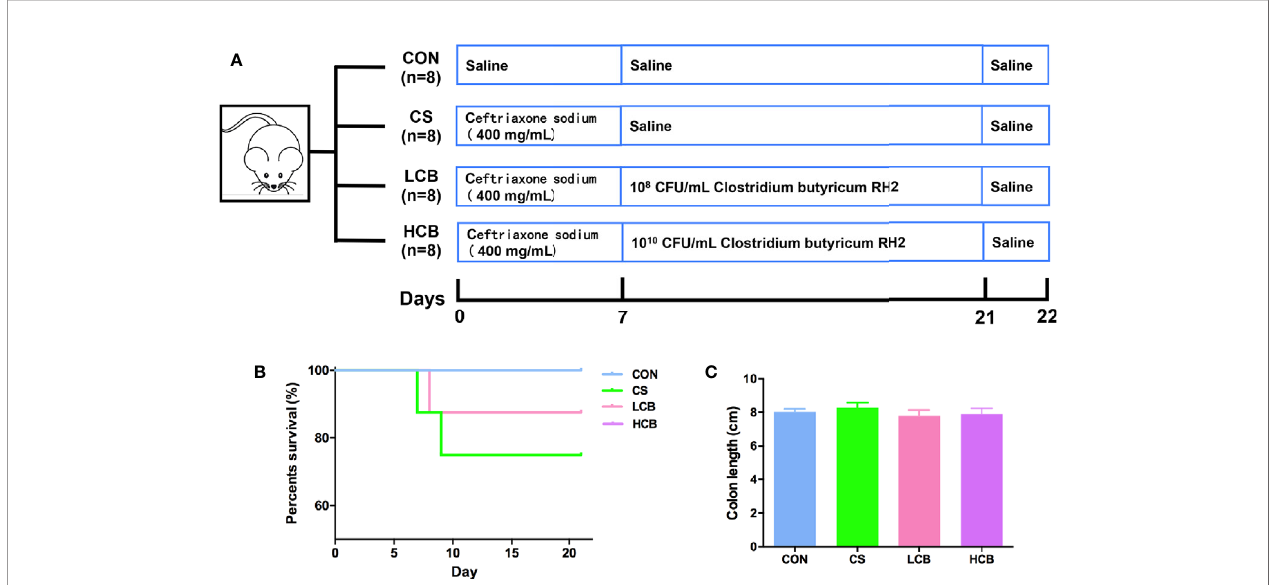
FIGURE 1 | Schematic overview of ceftriaxone treatment and CB RH2 administration. (A) Experimental protocol for ceftriaxone treatment with administration of CB RH2 as intervention; (B) Survival rate; (C) Colon length (cm), data are represented as mean ± SEM of eight mice in each